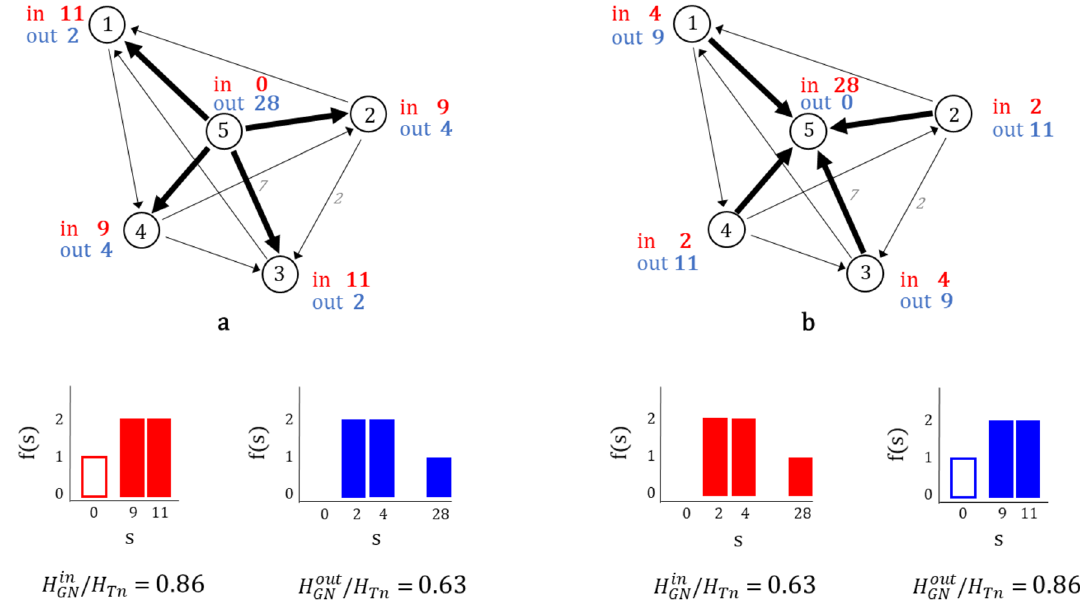
Figure 1. Global nodal entropy. Example of two different commuting networks. The node strength ( s ) measures the strength of nodes by means of the total weight of their connections, which in this case corresponds to the total amount of in- or out- flow at every node. The distribution f(s) for in-commuting is in red and for out- commuting is in blue. In the example above, when flows are more uniformly distributed in nodes, the H GN is higher, and when there are fewer nodes concentrating the flows, the H GN is